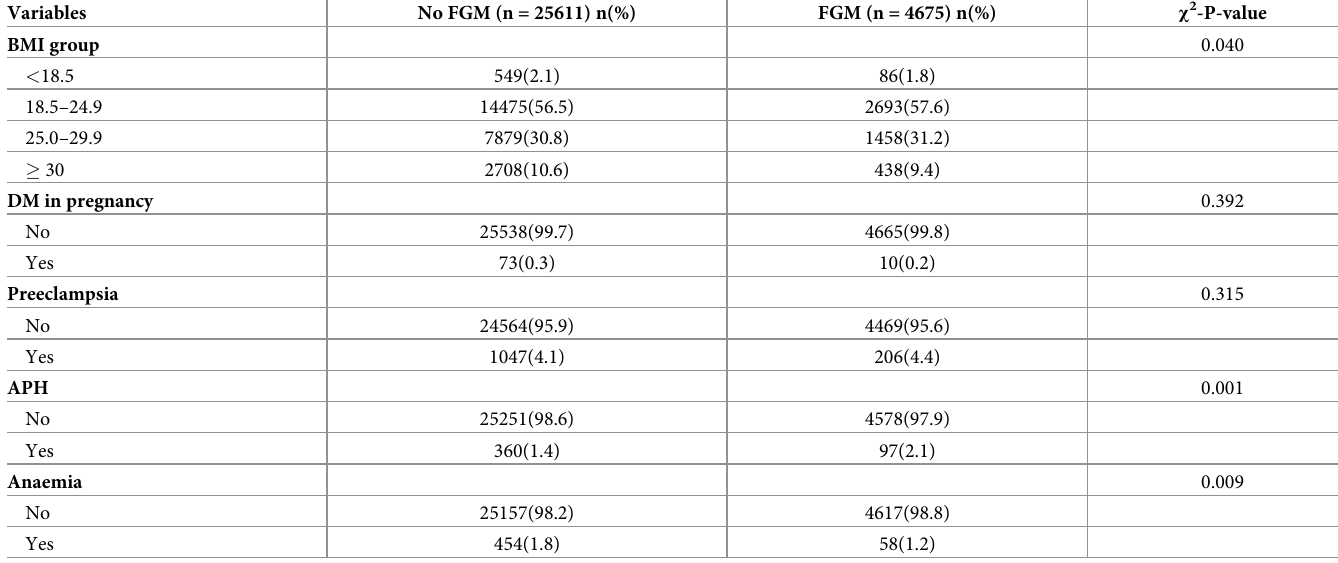
Table 2. Medical conditions during pregnancy (N =